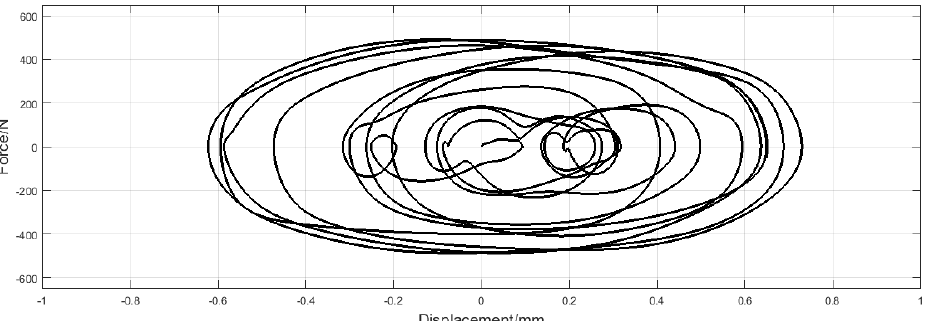
Figure 17. MR force versus its relative motion when operating in closed-loop using a PSO/BELBIC